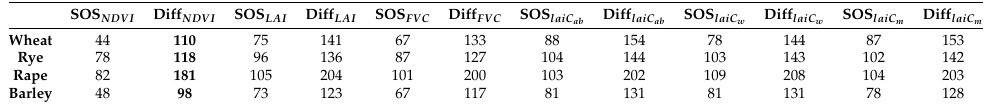
Figure 8. Time series profiles of the different crops: red dots indicate the original estimates, the green dots give the GPR-reconstructed retrievals. See Figure 2 for the geo-information. Derived SOS, EOS, and POS are indicated along with sowing and havest dates. Table 2. Mean values of Start of Season (SOS) in day of year and its mean difference from the sowing date (Diff) in days, for each crop trait and crop type. The smallest differences are written in bold.